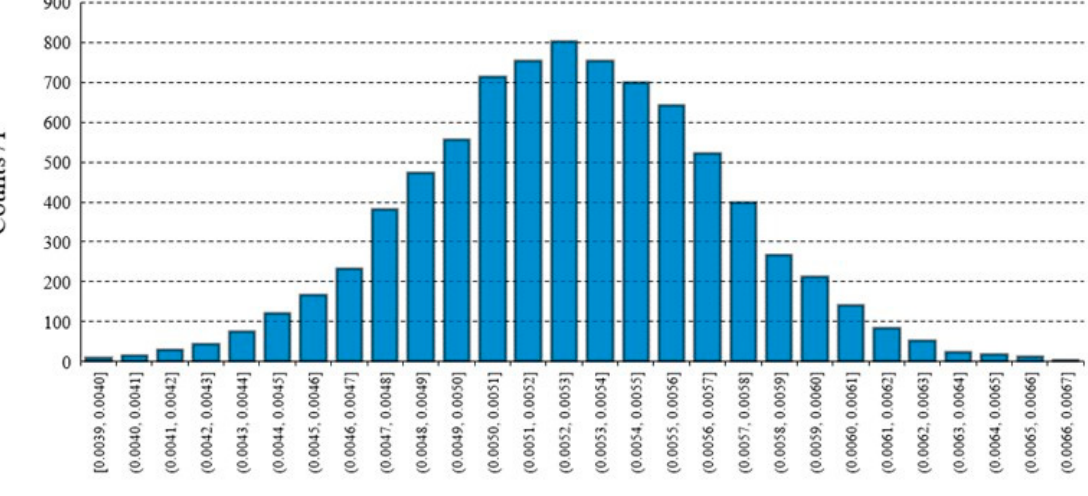
Figure 14. Sensitivity coefficient of the SBE35 s/n 0081 obtained with the Monte Carlo method with 8192 trials—best estimate a 1 = 0.0053 mK ∙ MPa − 1 and variance σ = 0.0004 mK ∙ MPa − 1 .